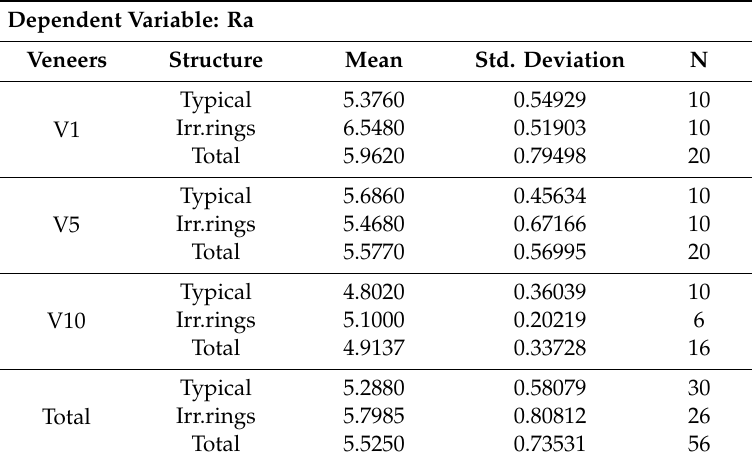
Figure 9. Surface roughness parameters Ra, Rz and Ry (µm) of ash heartwood veneers (V1, V5, V10) on typical wood structure areas and in areas of eccentric annual rings (spiral grain) of the wood near the trunk base, also bearing discoloration. Table 4. Descriptive statistics of dependent variable Ra measured on ash stump veneers of typical wood structure areas and areas of eccentric annual rings and discoloration.